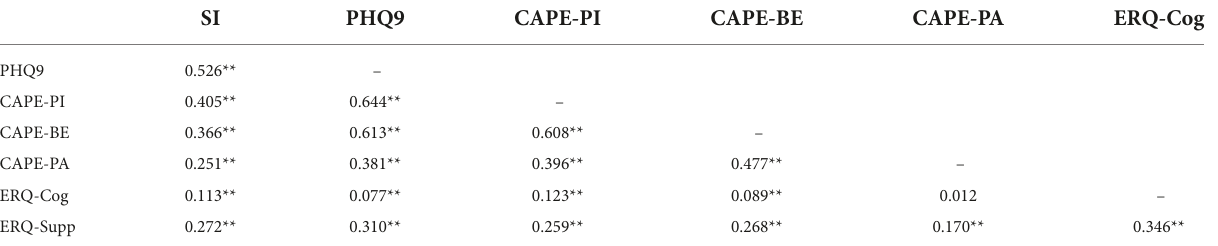
TABLE 2 Relationship between suicidal ideation, depression, psychotic experiences, and emotion regulation. SI PHQ9